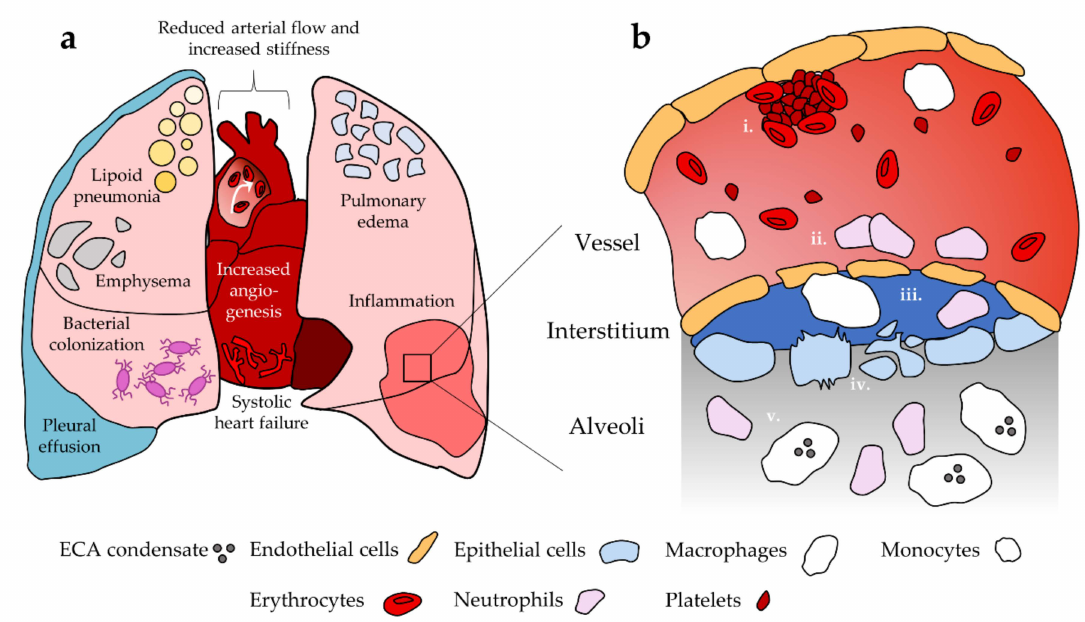
Figure 1. Summary of pulmonary and cardiovascular dysfunction and their cellular basis. ( a ) EC use has been linked to disease and dysfunction in the heart and lungs. ( b ) i. Platelets are activated towards a pro-thrombotic phenotype in the vessel; ii. ECA exposure promotes endothelial cell death and compromised barrier function, which facilitates immune cell extravasation into the surrounding tissue. Endothelial cells release inflammatory cytokines that enhance neutrophil recruitment; iii. Monocytes differentiate into macrophages upon extravasation. Neutrophils and macrophages